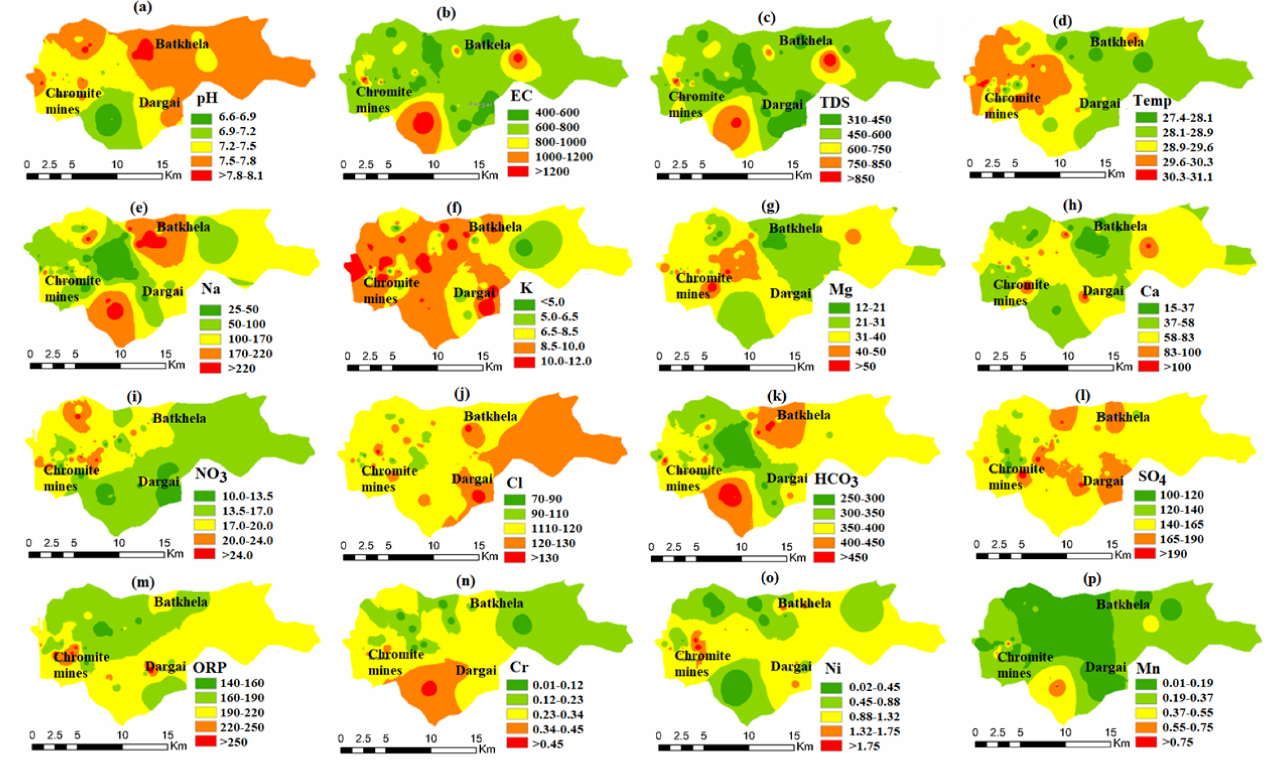
Figure 4. Spatial distribution pattern of physicochemical variables and HMs such as ( a ) pH, ( b ) EC, ( c ) TDS, ( d ) temperature, ( e ) Na, ( f ) K, ( g ) Mg, ( h ) Ca, ( i ) NO 3 ), ( j ) Cl, ( k ) HCO 3 , ( l ) SO 4 , ( m ) ORP, ( n ) Cr, ( o ) Ni, and ( p ) Mn, in groundwater system of the study